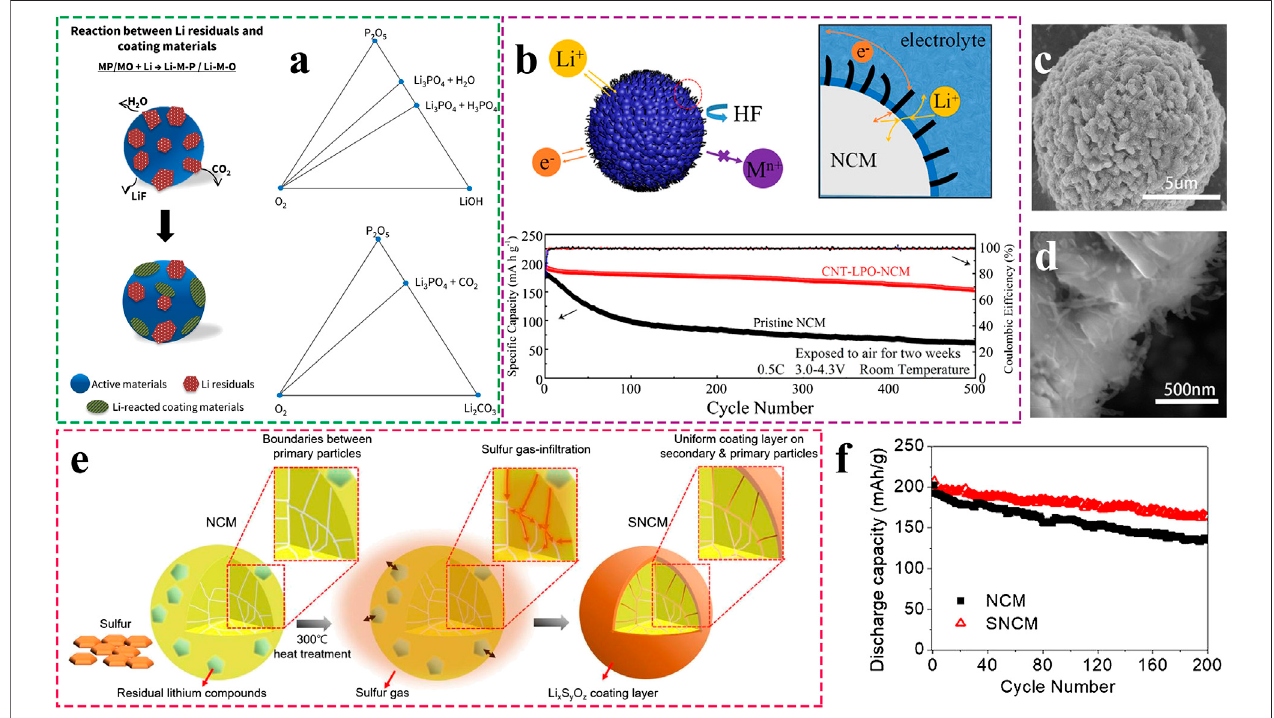
FIGURE4|(A) SchematicviewsoftheLi-reactivecoatingprocessandphasediagramforP 2 O 5 − LiOH/Li 2 CO 3 − O 2 .Adaptedfrom[Minetal.,2017]withpermission from American Chemical Society. (B) Schematic diagrams of the workingmechanism ofCNT& Li 3 PO 4 coating layer and cycling stability ofCNT& Li 3 PO 4 coated sample compared to pristine and (C and D) SEM images of the CNT& Li 3 PO 4 coated sample. Adapted from [Yang et al., 2019c] with permission from American Chemical Society. (E) Schematic views of the sublimation-induced gas-reacting process on the surface and inside of the secondary particles and (F) The improved cycling performance of surface Li x S y O z coated sample. Adapted from [Kim et al., 2020] with permission from American Chemical Society.